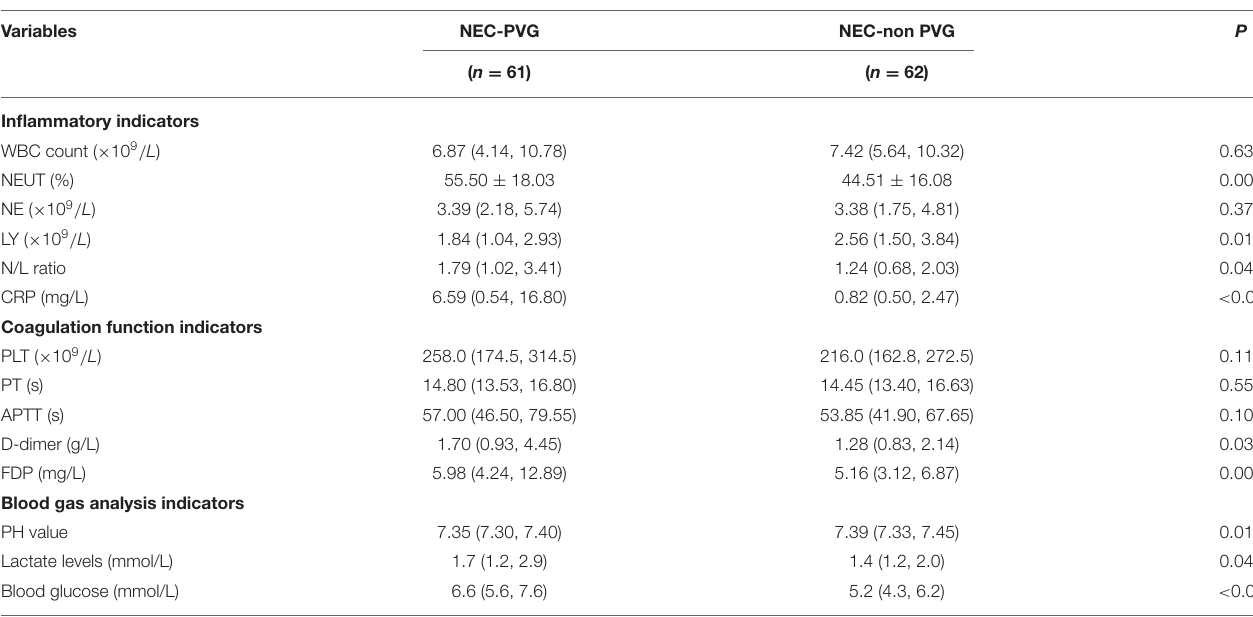
TABLE 2 | Laboratory parameters of NEC-PVG group and NEC-non PVG